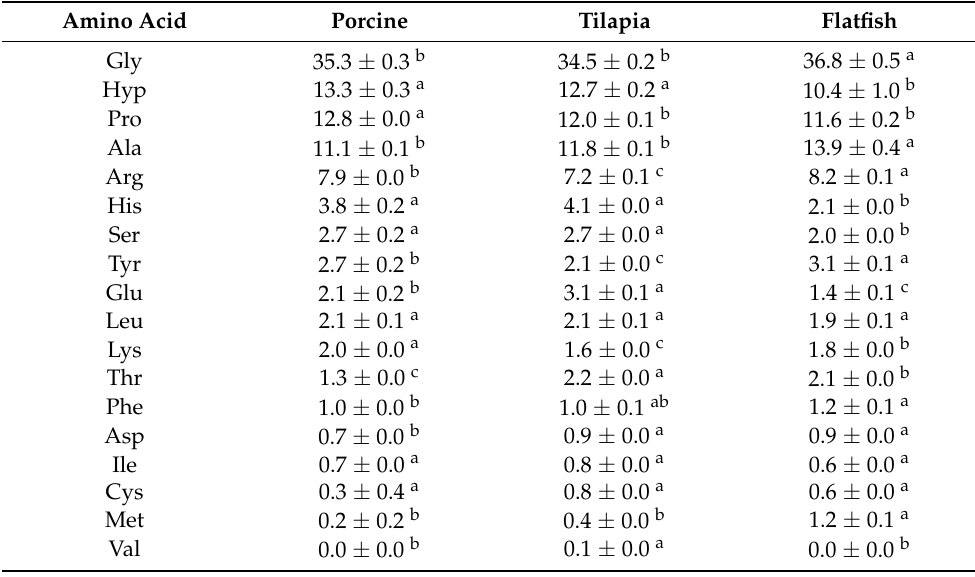
Table 1. Amino acid composition of collagen.